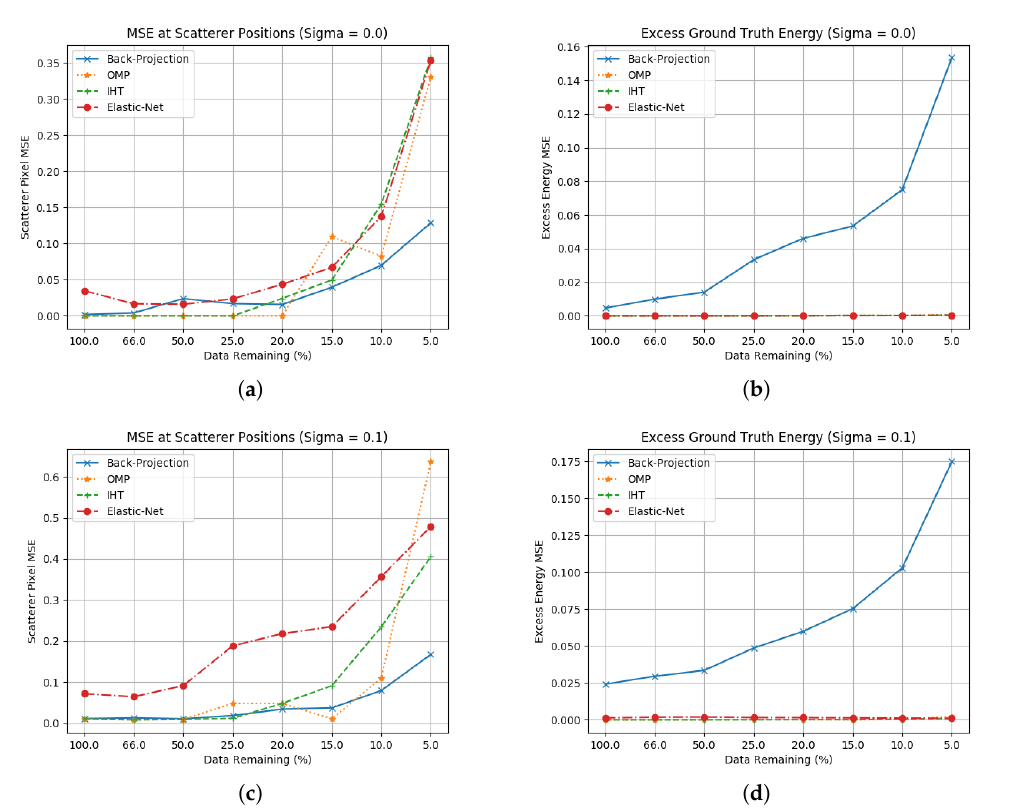
Figure 10. Ground truth estimation statistics for 50 randomly-placed scatterers. ( a ) Scatterer location RCS error without noise; ( b ) Excess energy without noise; ( c ) Scatterer location RCS error including noise ( σ = 0.1); ( d ) Excess energy including noise ( σ =